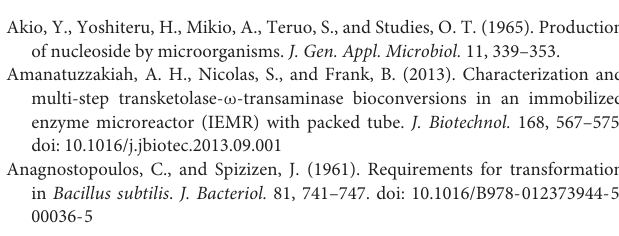
Supplementary Table 1 | Strains and plasmids used in this study. Supplementary Table 2 | Primers used in this